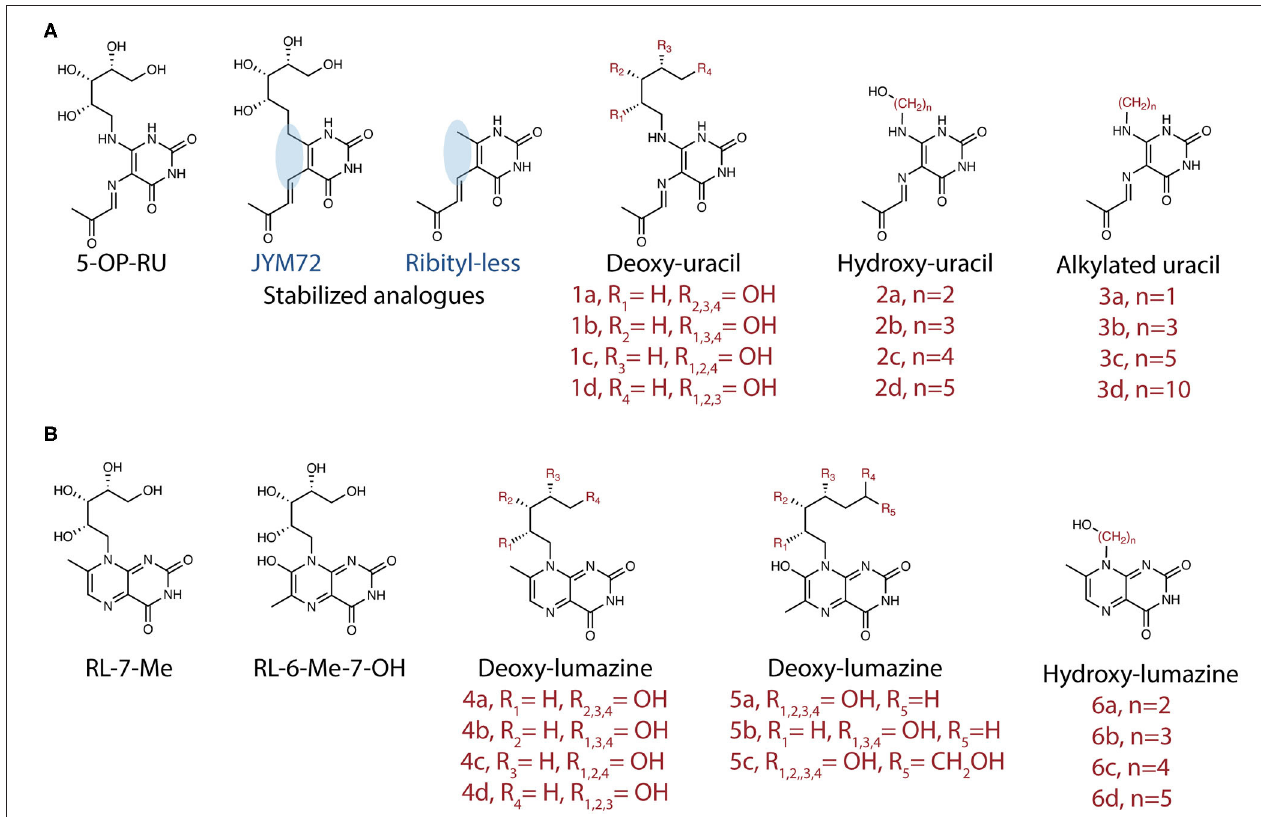
FIGURE 2 | Synthetic analogs of (A) pyrimidine antigen 5-OP-RU or (B) lumazines RL-7-Me and RL-6-Me-7-OH have been created to understand how different modifications impact MR1 binding and MAIT cell activation or inhibition.